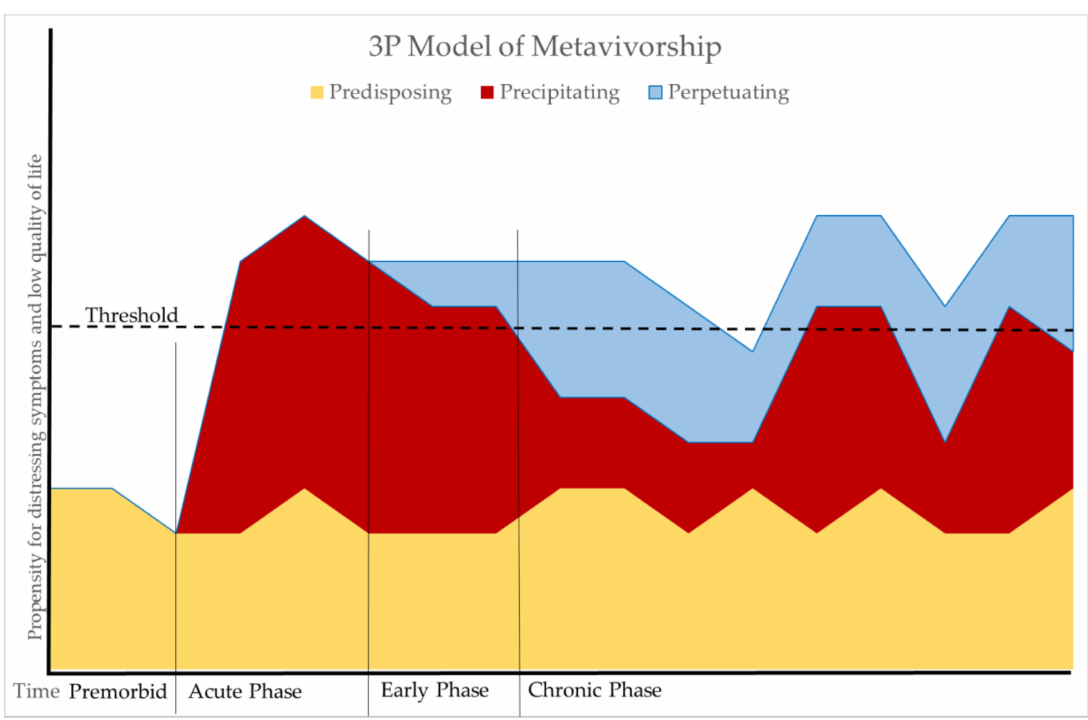
Figure 1. The predisposing, precipitating, and perpetuating (3P) Model of Metavivorship. Predisposing factors may vary over time in their contribution to distressing symptoms and low quality of life. In the premorbid phase prior to diagnosis of metastatic or recurrent disease, predisposing factors are the sole contributor to risk for developing distressing symptoms. Precipitating factors begin in the acute phase, begin to decline in the early phase, but may vary throughout the chronic phase due to various treatments and disease monitoring. Perpetuating factors begin in the early phase and can sustain symptoms and a ff ect quality of life throughout the chronic